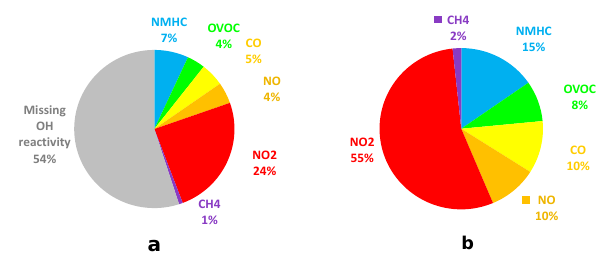
Fig. 11. Breakdown of the (a) total OH reactivity and (b) calculated OH reactivity for the entire MEGAPOLI winter campaign. Average total OH reactivity values were respectively 40.3 s − 1 (a) and 17.5 s − 1 (b)